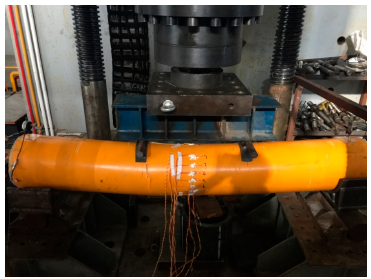
Figure 3. Bending test setup.